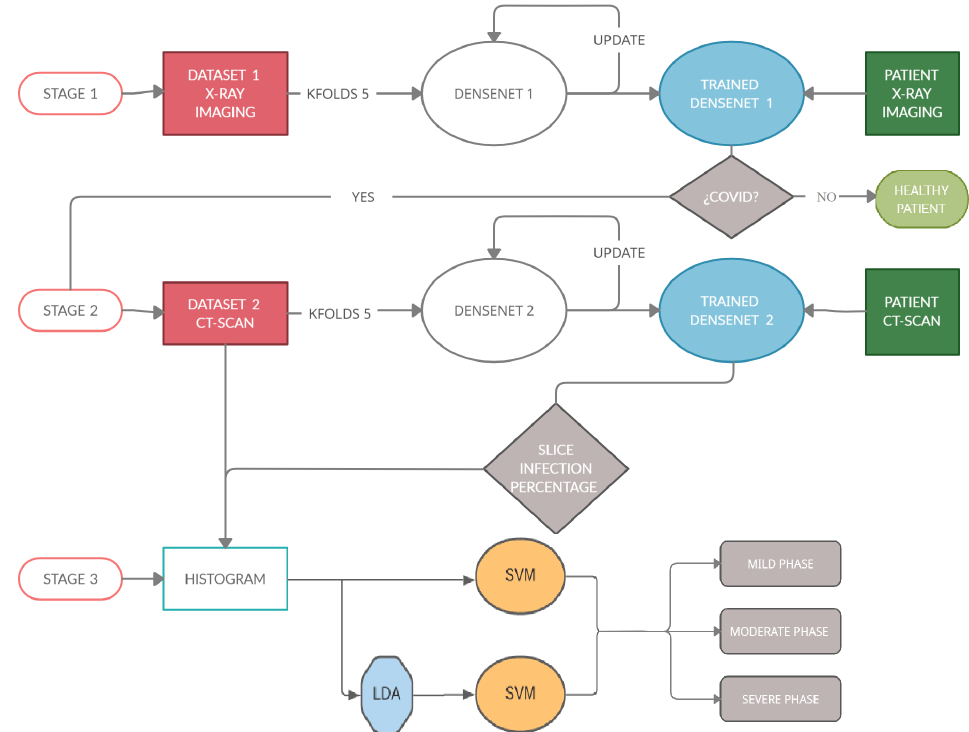
Figure 3. This diagram shows the architecture of the algorithm. (Stage 1): detect if a patient is sick with COVID-19 by studying their chest X-ray images. For this, a Densenet-161 network is used. (Stage 2) detects the percentage of infection in the lungs of a patient with COVID-19. In this stage, another Densenet-161 network is used. (Stage 3) classifies a patient within three degrees of gravity. For this purpose, a novel approach is proposed in which a histogram database is created with patients with different infection percentages. SVM with LDA is used to classify the patients in three degrees of